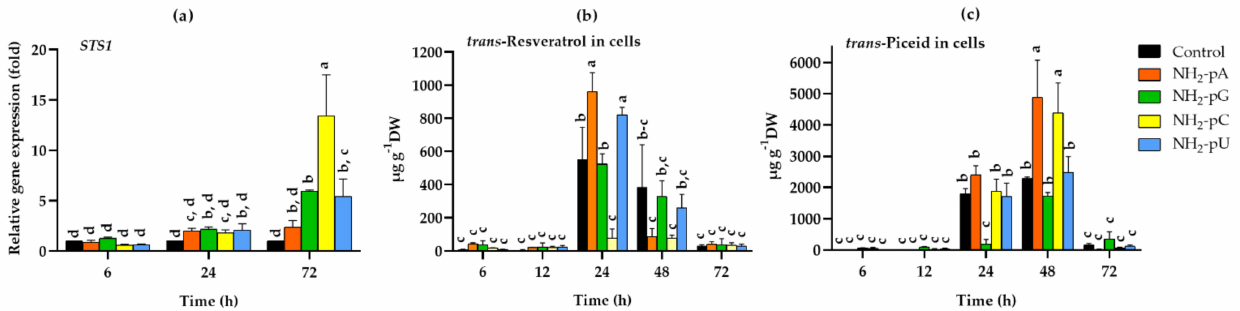
Figure 4. Expression of stilbene synthase gene ( STS1) and accumulation of stilbenes in cells of Vitis vinifera cv. Monastrell treated with 5 µ M nucleoside 5 (cid:48) -phosphoramidates. ( a ) STS1 , stilbene synthase; ( b ) accumulation of trans -resveratrol; ( c ) accumulation of trans -piceid. Total RNA was reverse-transcribed into cDNA and used as a template for real-time quantification PCR reaction as described in the Section 4. Specific primers were designed for STS1 and EF α 1 (elongation factor 1-alpha, which was used as an endogenous control). The expression level of STS1 in the control cells (no nucleotide added) was set to 1. Values represent the mean ± standard deviation of the three replicates. Accumulation of trans - resveratrol and trans -piceid was determined using the HPLC method as described in the Section 4. Values without a common letter are significantly different according to ANOVA and Tukey’s HSD multiple range test ( p ≤